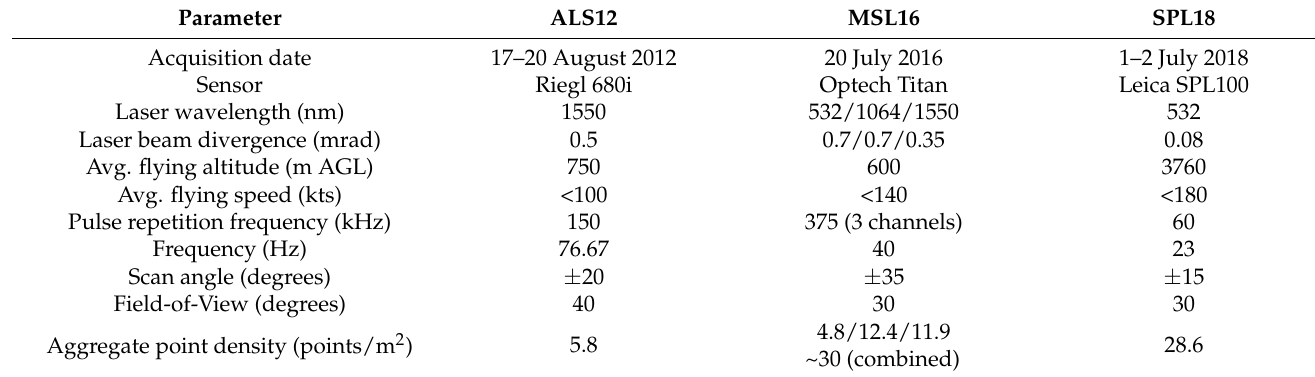
Table 1. Acquisition parameters and information for lidar